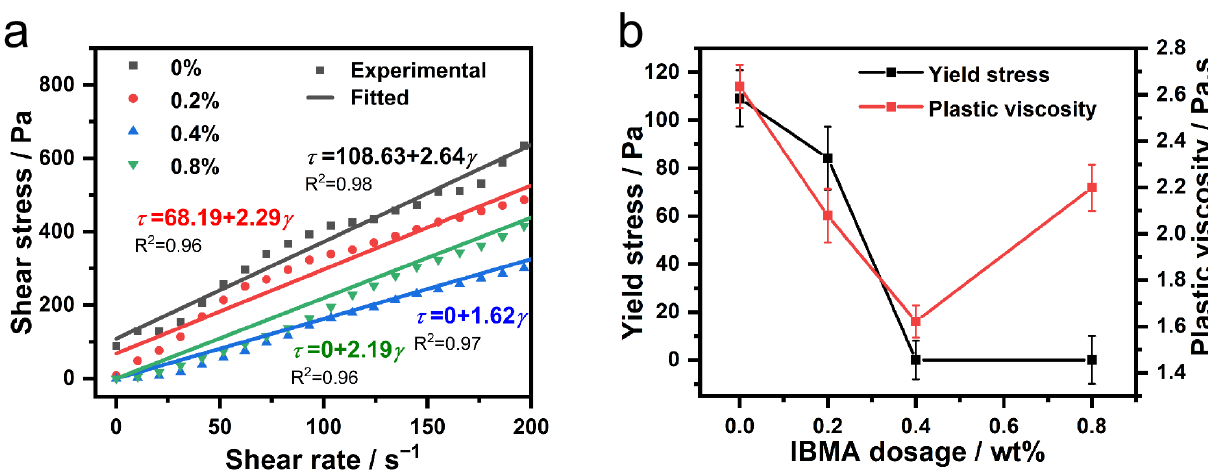
Figure 7. Rheological properties of fresh NHL pastes. ( a ) Rheological measurements and fitting curves of the IBMA – NHL pastes. ( b ) Yield stress and plastic viscosity of fresh NHL pastes with varying IBMA content.